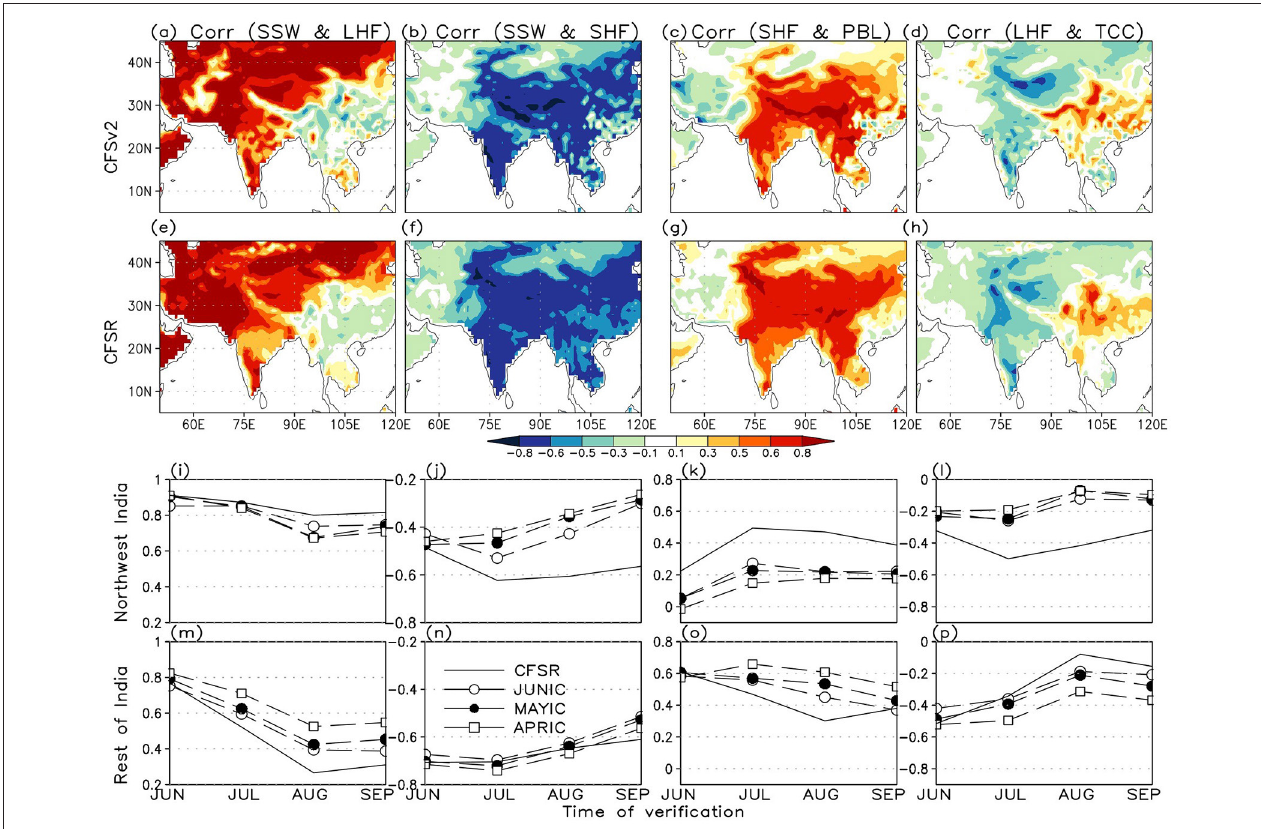
FIGURE 4 | Ensemble-mean correlation of daily SSW with (a) LHF and (b) SHF; and (c) SHF with PBL height, and (d) LHF with TCC in JJAS from CFSv2 JUNIC hindcasts. (e–h) respectively, show similar correlations based on the CFSR. (i–p) show monthly correlations for the same variables for the northwest and rest of India domains, respectively; from JUNIC, MAYIC, and APRIC hindcasts and CFSR.